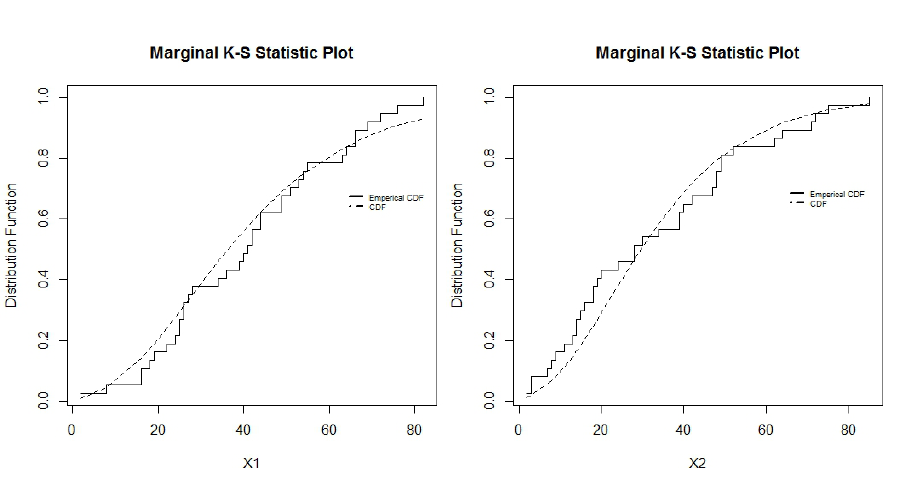
Figure 7 – K-S plot for data set X